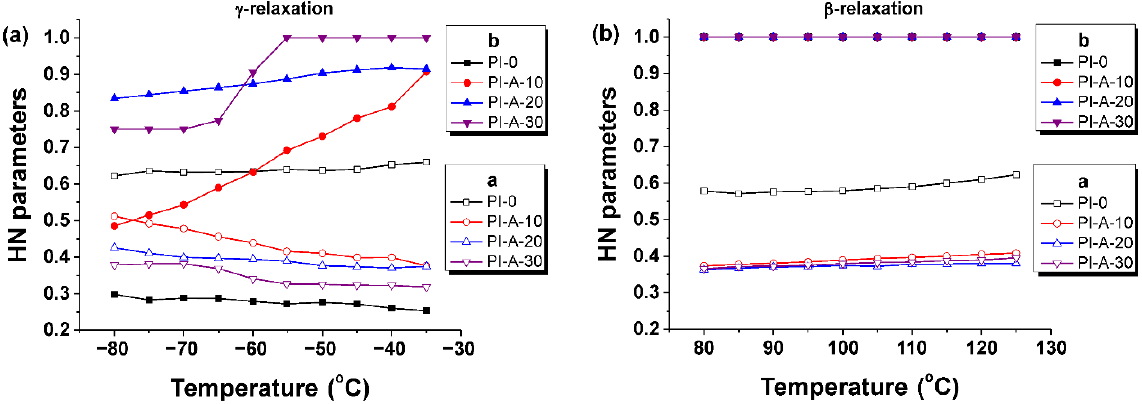
Figure 8. Broadening and skewing parameters as function of temperature for γ ( a ) and β ( b ) relaxations of PI-0, PI-A-10, PI-A-20, and PI-A-30.